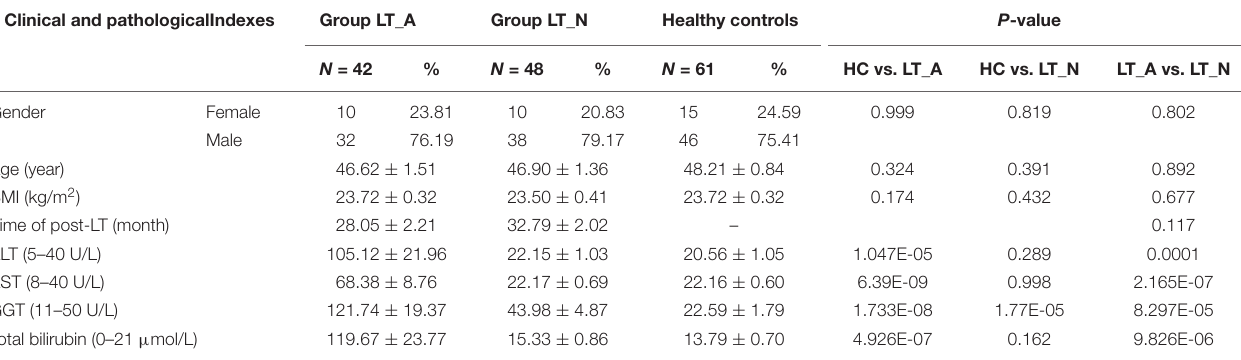
TABLE 1 | Clinical information in liver recipients and healthy controls. Clinical and